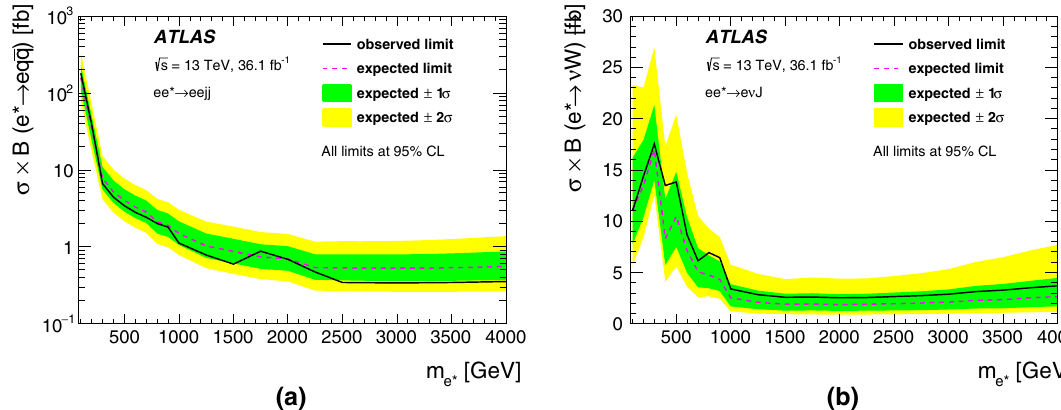
Fig. 5 Upper limits on σ × B as a function of m e ∗ in a the eejj channel and b the e ν J channel. The ± 1 ( 2 )σ uncertainty bands around the expected limit represent all sources of systematic and statistical uncertainties